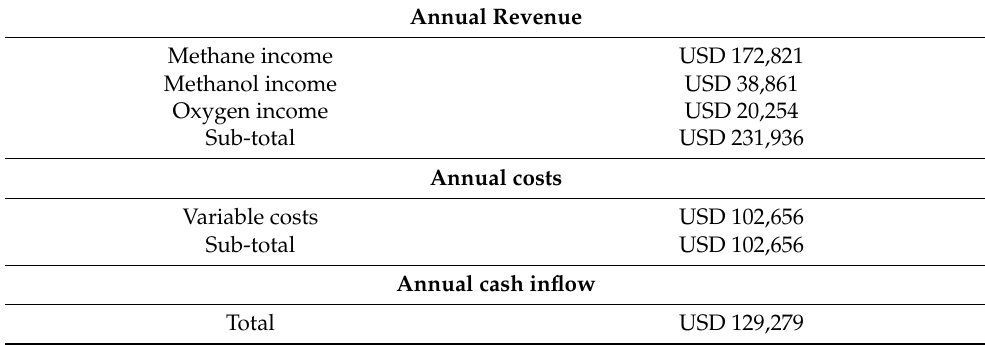
Table 5. Summary of annual cash inflow.